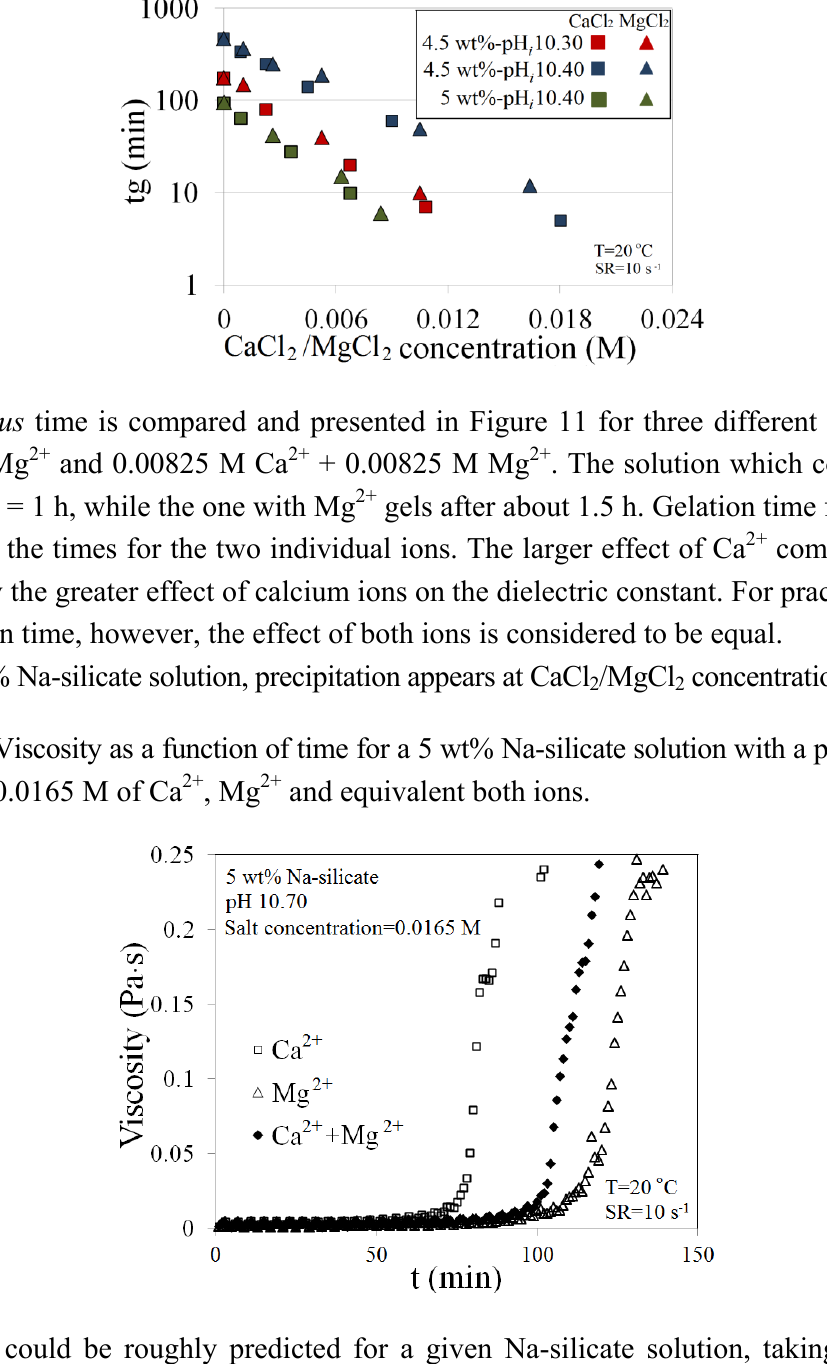
Figure 10. Gelation time as a function of CaCl and 5 wt% Na-silicate solutions with pH